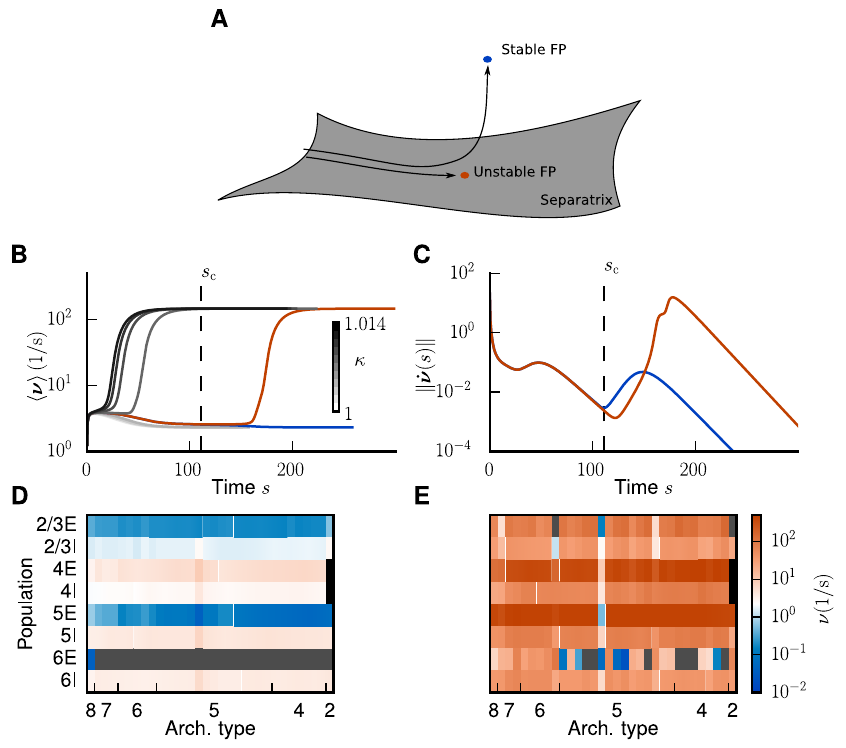
Fig 4. Application of the mean-field theory to the multi-area model. A Trajectories of Eq (1) starting insidethe separatrix convergeto an unstablefixed point. Trajectoriesstarting close to the separatrixare initiallyattracted by the unstable fixed point but then repelledin the fixed point’sunstable directionand finally convergeto a stable fixed point. B Firing rate averagedacross populations over time. Integrationof Eq (1) leads to convergence to either the low-activity (LA) or the high-activity(HA) attractor for different choices of the externalinput factor k , with k ¼ 1 the originallevel of externaldrive. We show eight curves with k varying from 1.0 to 1.014 in steps of 0.002 and two additional curves for k ¼ 1 : 007662217 ; 1 : 007662218 . The curves for the largest factor ð k ¼ 1 : 007662217 Þ that still leads to the LA state and for the smallest factor ð k ¼ 1 : 007662218 Þ that leads to the HA state are marked in blue and red, respectively. The four curves with k (cid:20) 1 : 006 coincide with the blue curve. C Euclidean norm of the velocity vector in the integrationof Eq (1) for the different choices of k . The vertical dashed line indicatesthe time s of the last local minimum in the blue curve. D Stationary c firing rate in the different areas and layers of the model in a low-activity state for k ¼ 1 : 0 as predictedby the mean-field theory (same displayas in Fig 3). E As D, but showingthe high-activity state for k ¼ 1 : 125